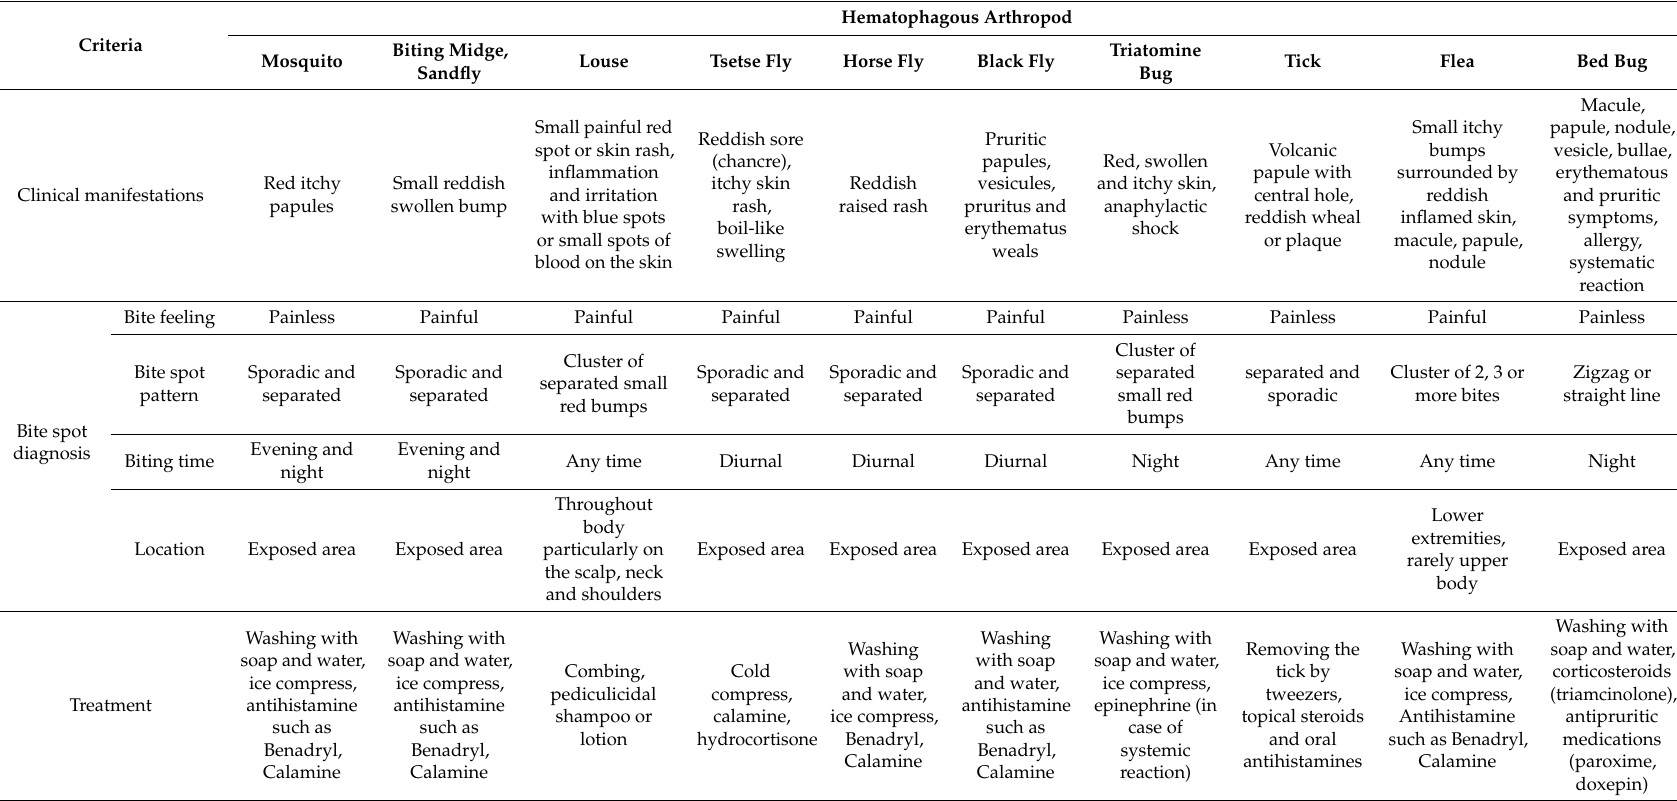
Table 2. Discriminative clinical characters associated with hematophagous arthropods